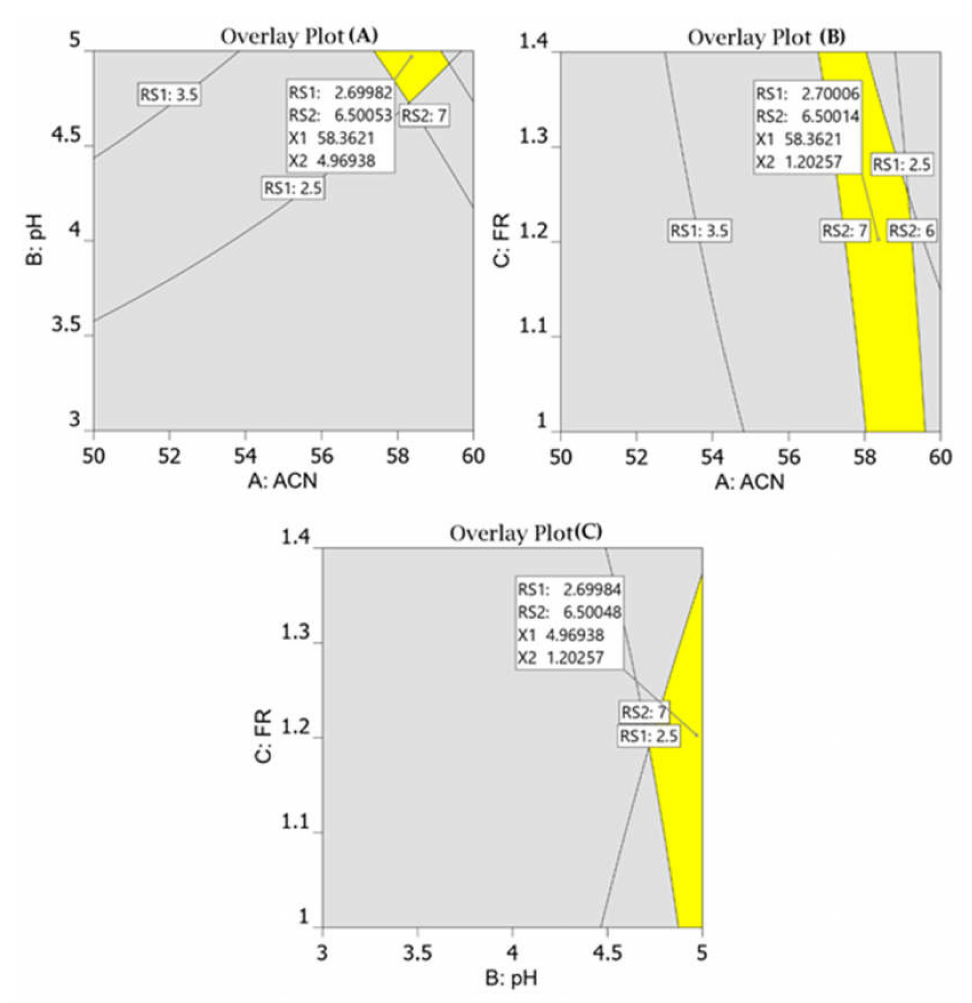
Figure 4. Overlay plots for optimum chromatographic conditions suggested by the Design-Expert software. The perctentage of acetonitrile against pH of mobile phase ( A ); flow rate against % of acetonitrile ( B ); flow rate against pH of the mobile phase ( C